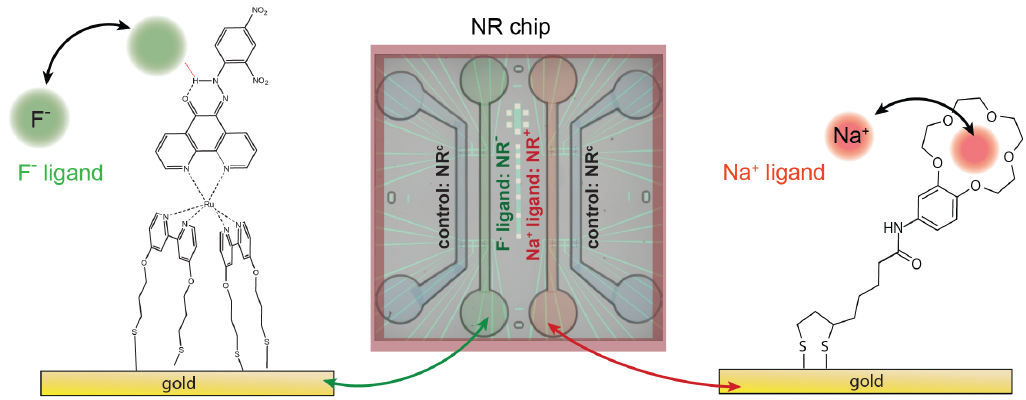
Figure 1. Schematics of the functionalization setup and molecular structure of the F − ligand ( Left ) and the Na + ligand ( Right ) immobilized on the gold surface; ( Middle ) schematics of the NR chip covered by microfluidic cell. Four channels are incorporated in our design, each containing 12 NRs (see Supplementary Materials for further details).The functionalization results in 24 functionalized NRs (12 NR + , 12 NR − ) and 24 control NRs (NR c